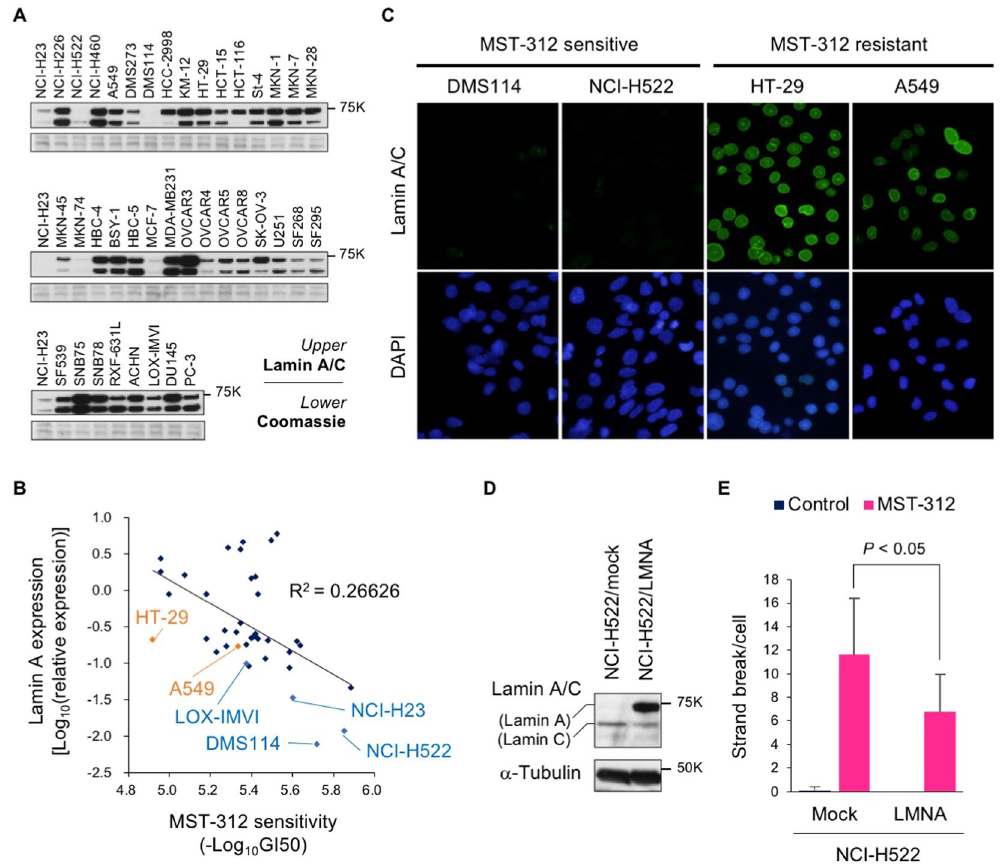
Figure 5. Lamin A prevents MST-312-induced DNA double strand breaks. ( A ) Western blot analysis of lamin A/C in the JFCR39 cancer cell line panel. Coomassie brilliant blue gel staining is shown to confirm equal loading. Three different blots or gels were derived from the same experiment and were processed in parallel. Each blot/gel contains NCI-H23 cells as a calibration standard. Full-length blots/gels were presented in Supplementary Fig. S5. ( B ) Correlation between MST-312 sensitivity and lamin A protein expression level in JFCR39. Representative cell lines are shown in orange and blue . GI 50 values were determined by the cell growth inhibition curve of 48-h treated cells in Fig. 1D. ( C ) Indirect immunofluorescence staining with anti-lamin A/C antibody ( green ). MST-312-sensitive [NCI-H522 (short telomeres) and DMS114 cells (super long telomeres)] and MST-312-resistant cells (HT-29, A549) are shown. DNA was counterstained with DAPI ( blue ). ( D ) Ectopic expression of lamin A in NCI-H522 cells. Cells were infected with retrovirus for expression of lamin A (LMNA) exogene and selected by hygromycin. The resulting cells, NCI-H522/mock and NCI-H522/LMNA, were subjected to western blot analysis. α -tubulin served as loading control. Full-length blots were presented in Supplementary Fig. S5. ( E ) Cells in ( D ) were treated with 5 μ M MST-312 for 48 h and further incubated with colcemid. Metaphase spreads of chromosomes were analysed for DNA double strand breaks. Error bar indicates standard deviation. Statistical significance was evaluated by Tukey-Kramer In vivo xenografts. Human breast cancer HBC-4 cells were implanted subcutaneously in the right flank region of 9-week-old BALB/cAJcl-nu nude mice (Charles River Laboratories Japan, Kanagawa, Japan). Experiments were started when tumours reached 50–150 mm 3 as measured with callipers (day 0). MST-312 was administered by either intratumoural injection at 40 or 80 μ g/day; intravenous injection at 30, 50 or 70 mg/kg/ day; or orally at 50, 200 or 400 mg/kg/day. In the intratumoural injection experiment, vehicle group was admin- istrated three times of once daily (qd) per week for four weeks and 40 and 80 μ g/day groups were administrated five times of qd per week for four weeks. In the intravenous injection experiment, vehicle and 30 mg/kg groups were administrated five times of qd per week for three weeks, 50 mg/kg group was administrated five times of qd per week for two weeks and 70 mg/kg group was three times of qd per week for three weeks. In the orally administrated group, 50 and 200 mg/kg groups were administrated five times of qd per week for nine weeks and 400 mg/kg group was administrated five times of qd per week for 6 weeks. Control mice (n = 5–6) received the same volume of saline as experimental mice (n = 5–6 per group). Tumour growth was monitored. The length (L) and width (W) of the tumours were measured, and the tumour volume (TV) was calculated as TV = LW 2 /2. All animal procedures were performed in the animal experiment room of the Japanese Foundation for Cancer Research (JFCR) using protocols approved by the JFCR Animal Care and Use Committee.